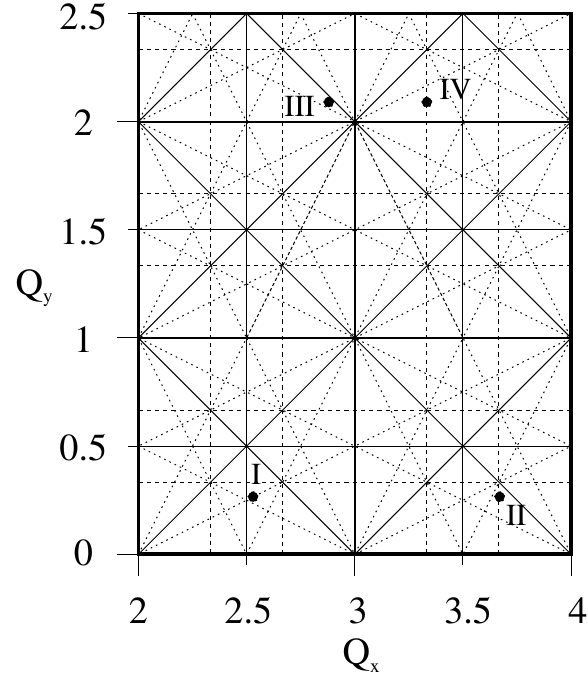
FIG. 4. Tune values in horizontal ( Q directions at working points I–IV